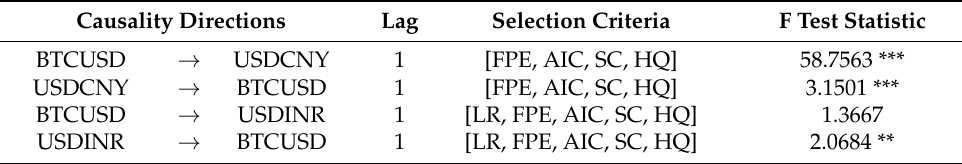
Table 5. Non-linear Causality Test. Causality